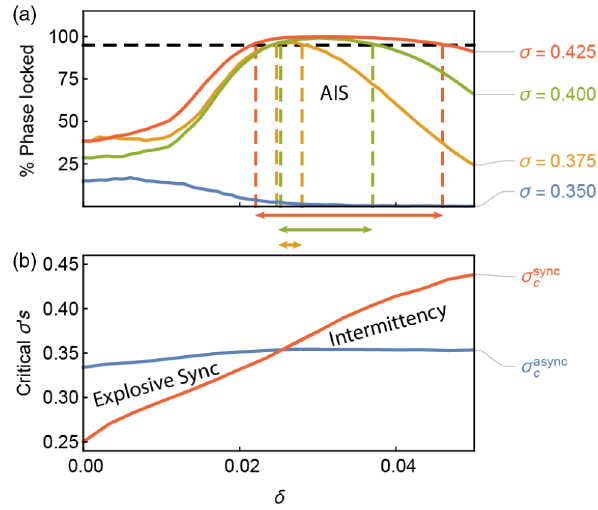
FIG. 10. Statistical confirmation of AIS for moderate hetero- geneity over many heterogeneity profiles. (a) Percentage of random initial conditions that become completely phase locked and (b) critical coupling strengths as functions of δ . The dashed lines and arrows show where the ring of Janus oscillators exhibits AIS given the 95% threshold. Each value of δ is probed for 10 4 different realizations of heterogeneity profiles and initial con- ditions to determine the percentages in (a) and 100 heterogeneity profiles for each of 100 different coupling constants to determine the critical values in